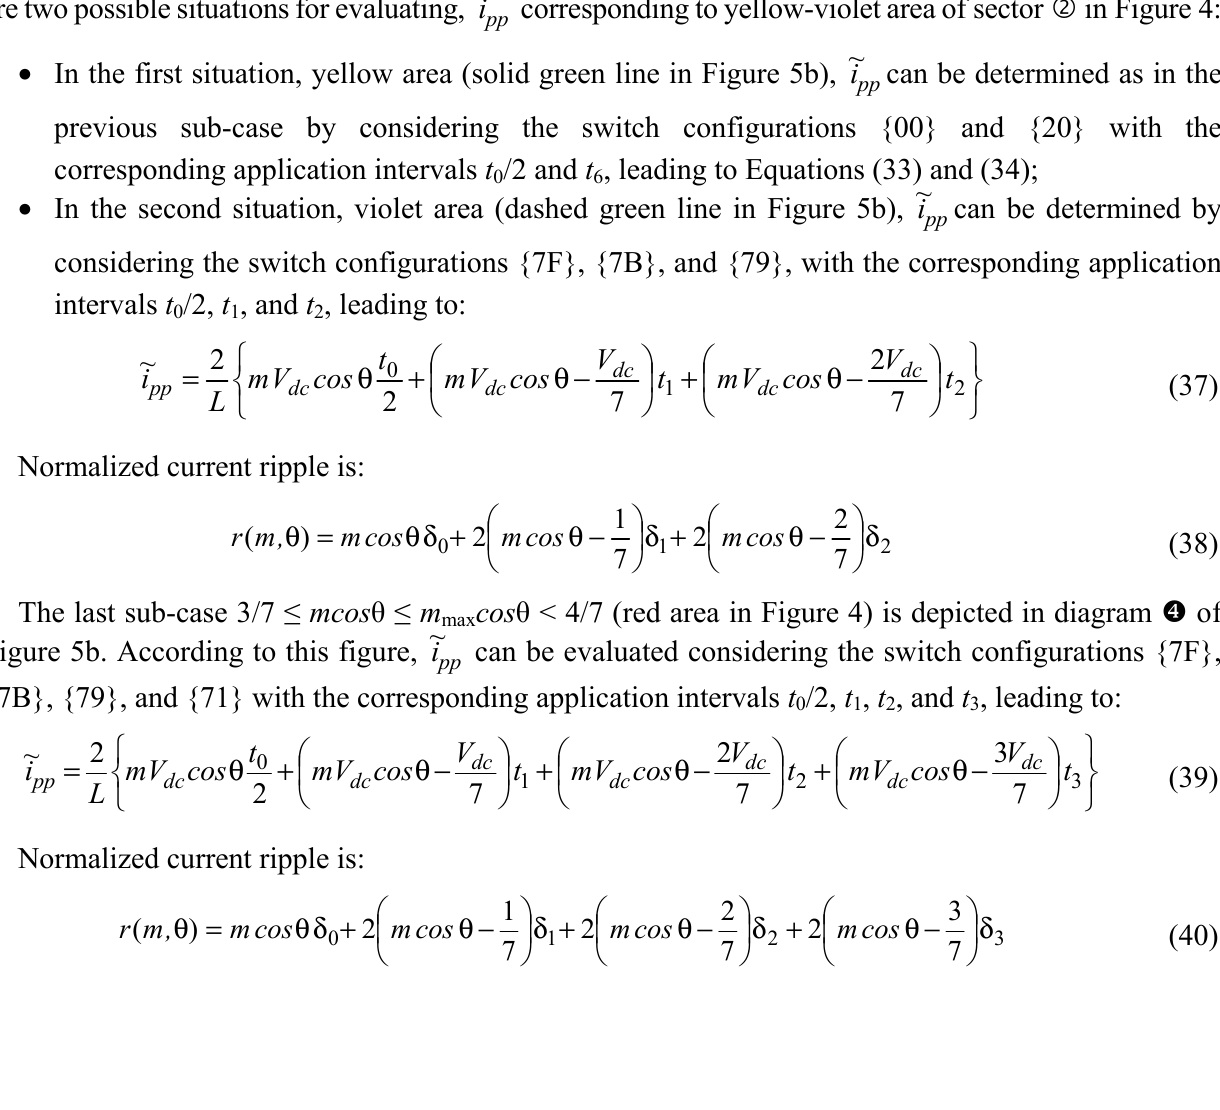
corresponding to yellow-violet area of sector  in Figure